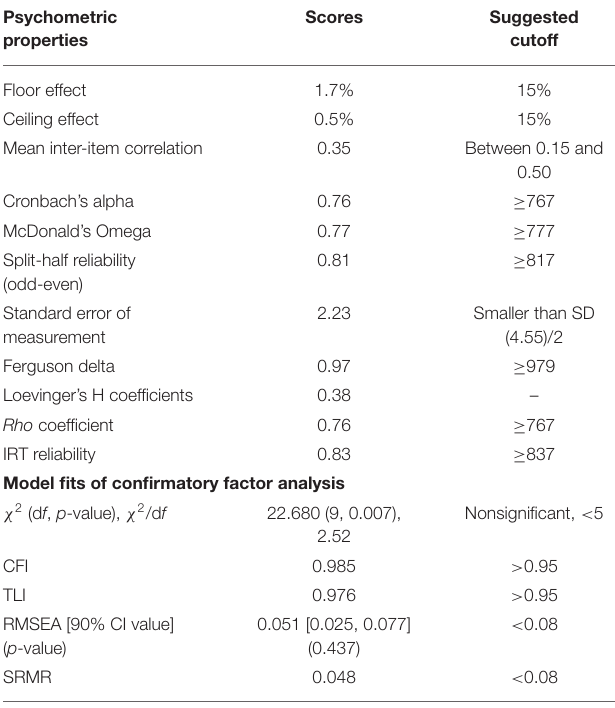
TABLE 3 | Scale level psychometric properties of the French–Canadian version of the SAVE-6 scale. Psychometric properties